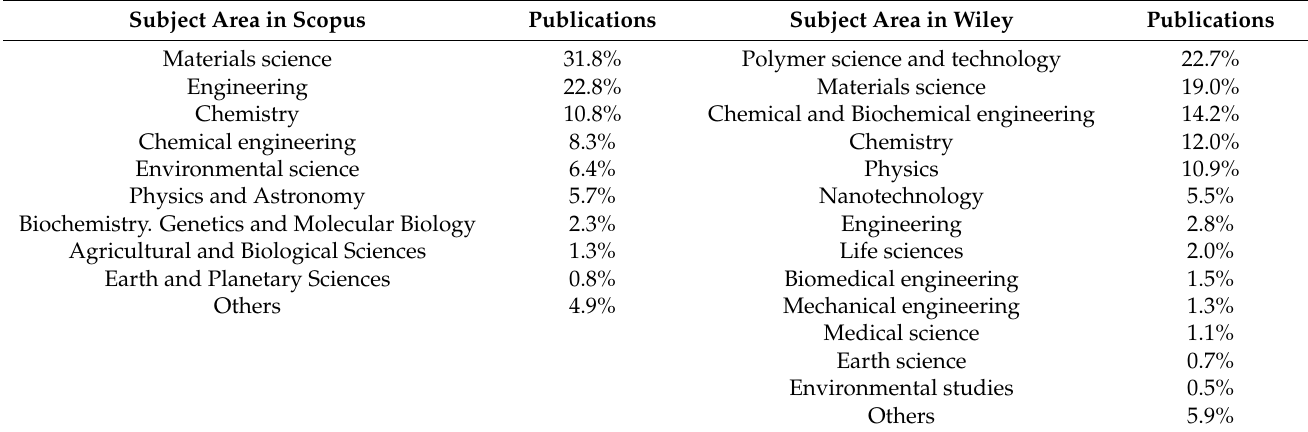
Table 2. Area of publications in Scopus and